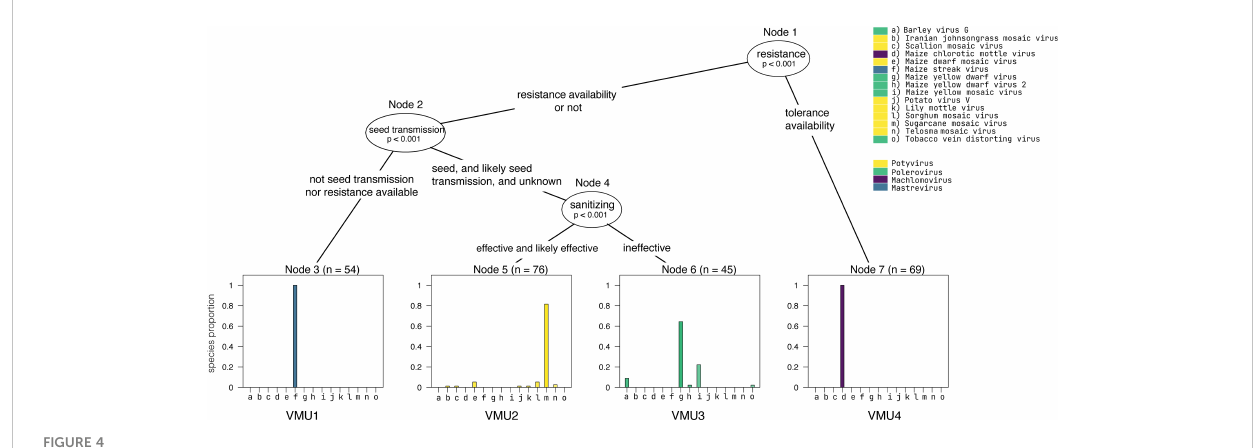
FIGURE 4 Virome management units associated with maize lethal necrosis, as described